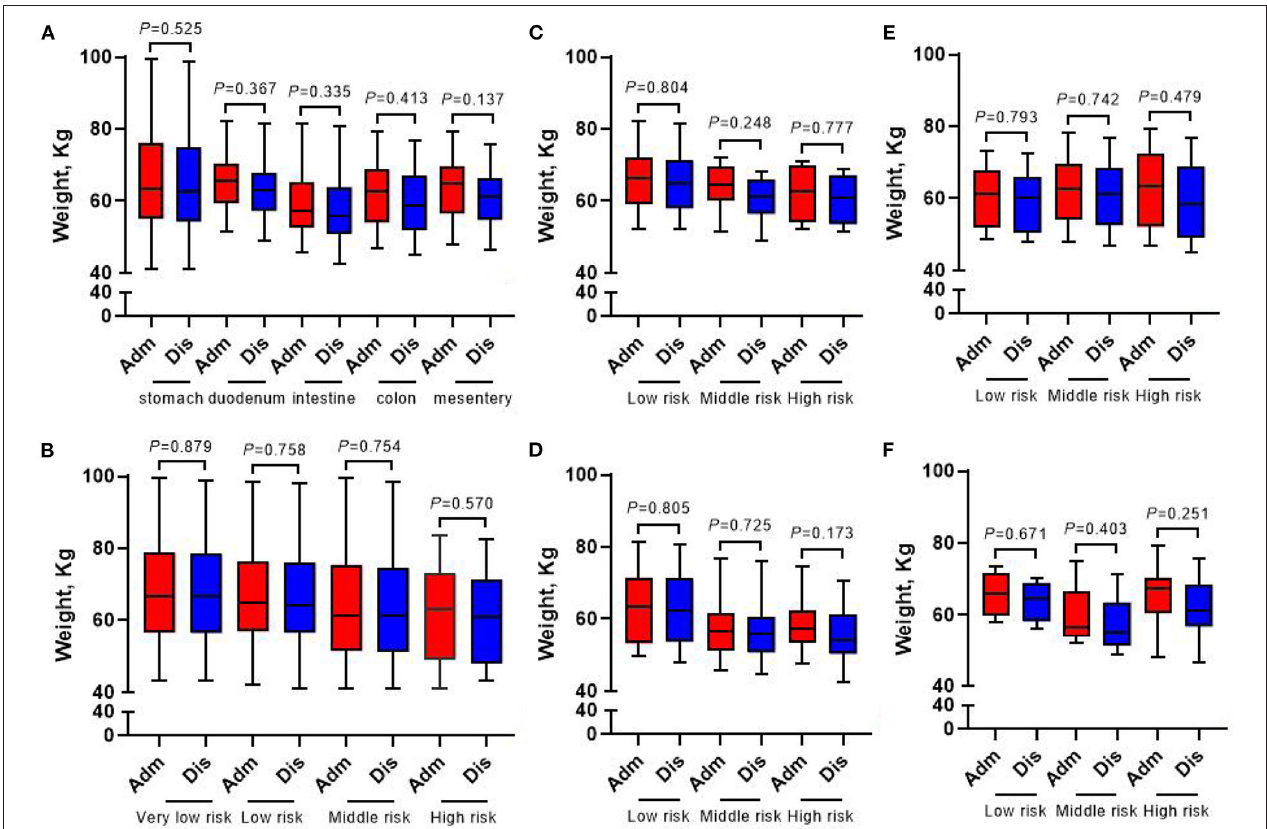
FIGURE 4 | Changes of weight in 413 GIST patients at admission and discharge. (A) Total; (B) stomach; (C) duodenum; (D) intestine; (E) colorectal; (F) mesentery.